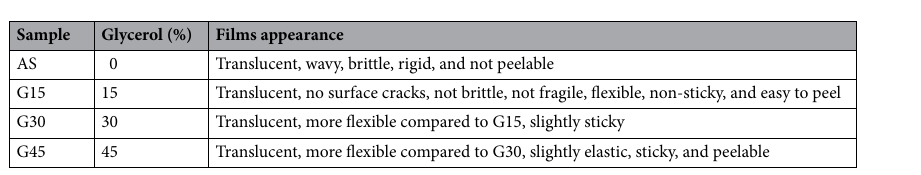
Table 2. The presence of control and G-plasticized AS